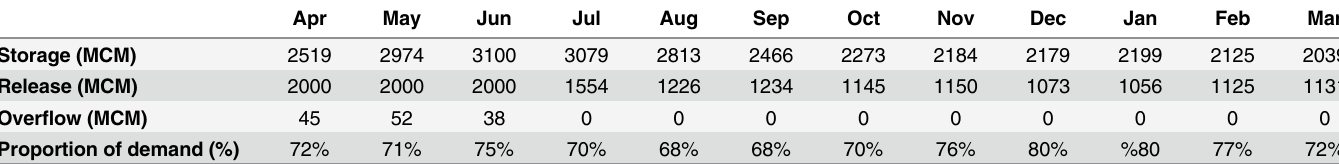
Table 2. The average reservoir storage, release rate, overflow rate and proportion of water demand of Karun 1 (while: λ 1 = 0.5 & λ 2 = 0.5).